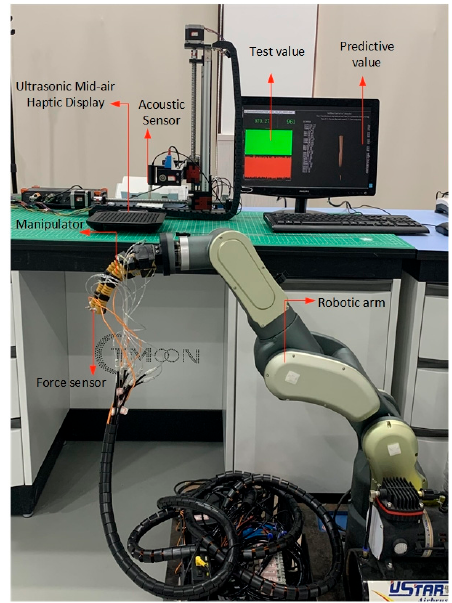
Figure 12. Test and verification experiment diagram in teleoperation system.